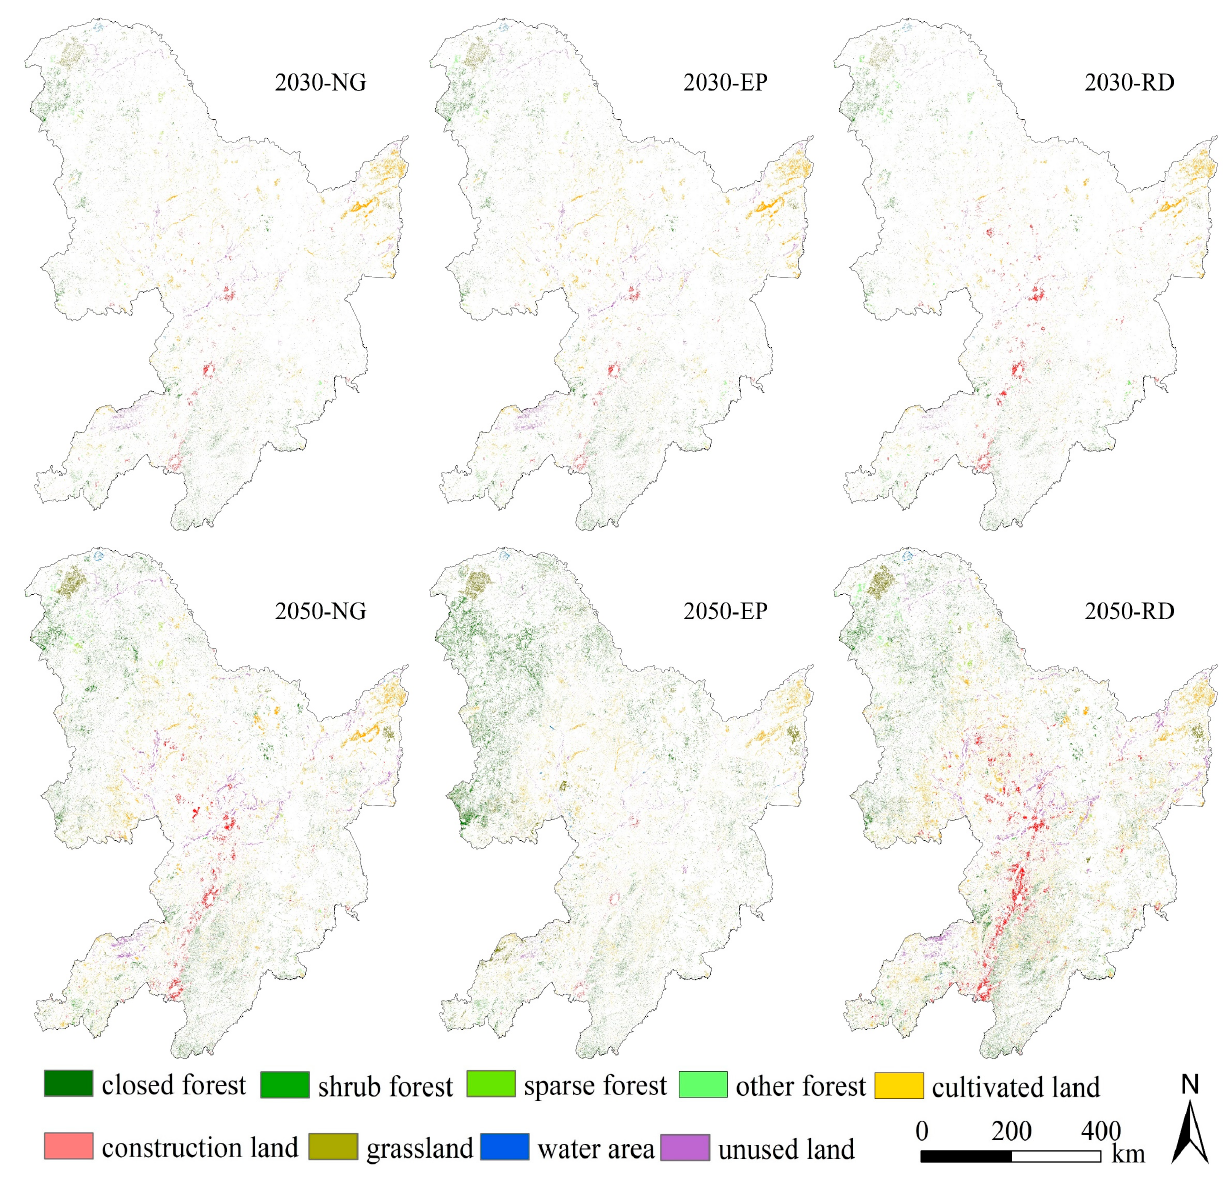
Figure 8. Future land expansion under different scenarios.